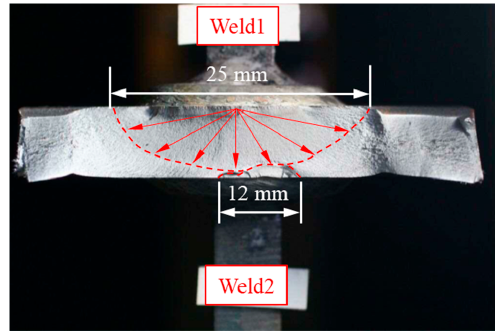
Figure 11. Crack initiation